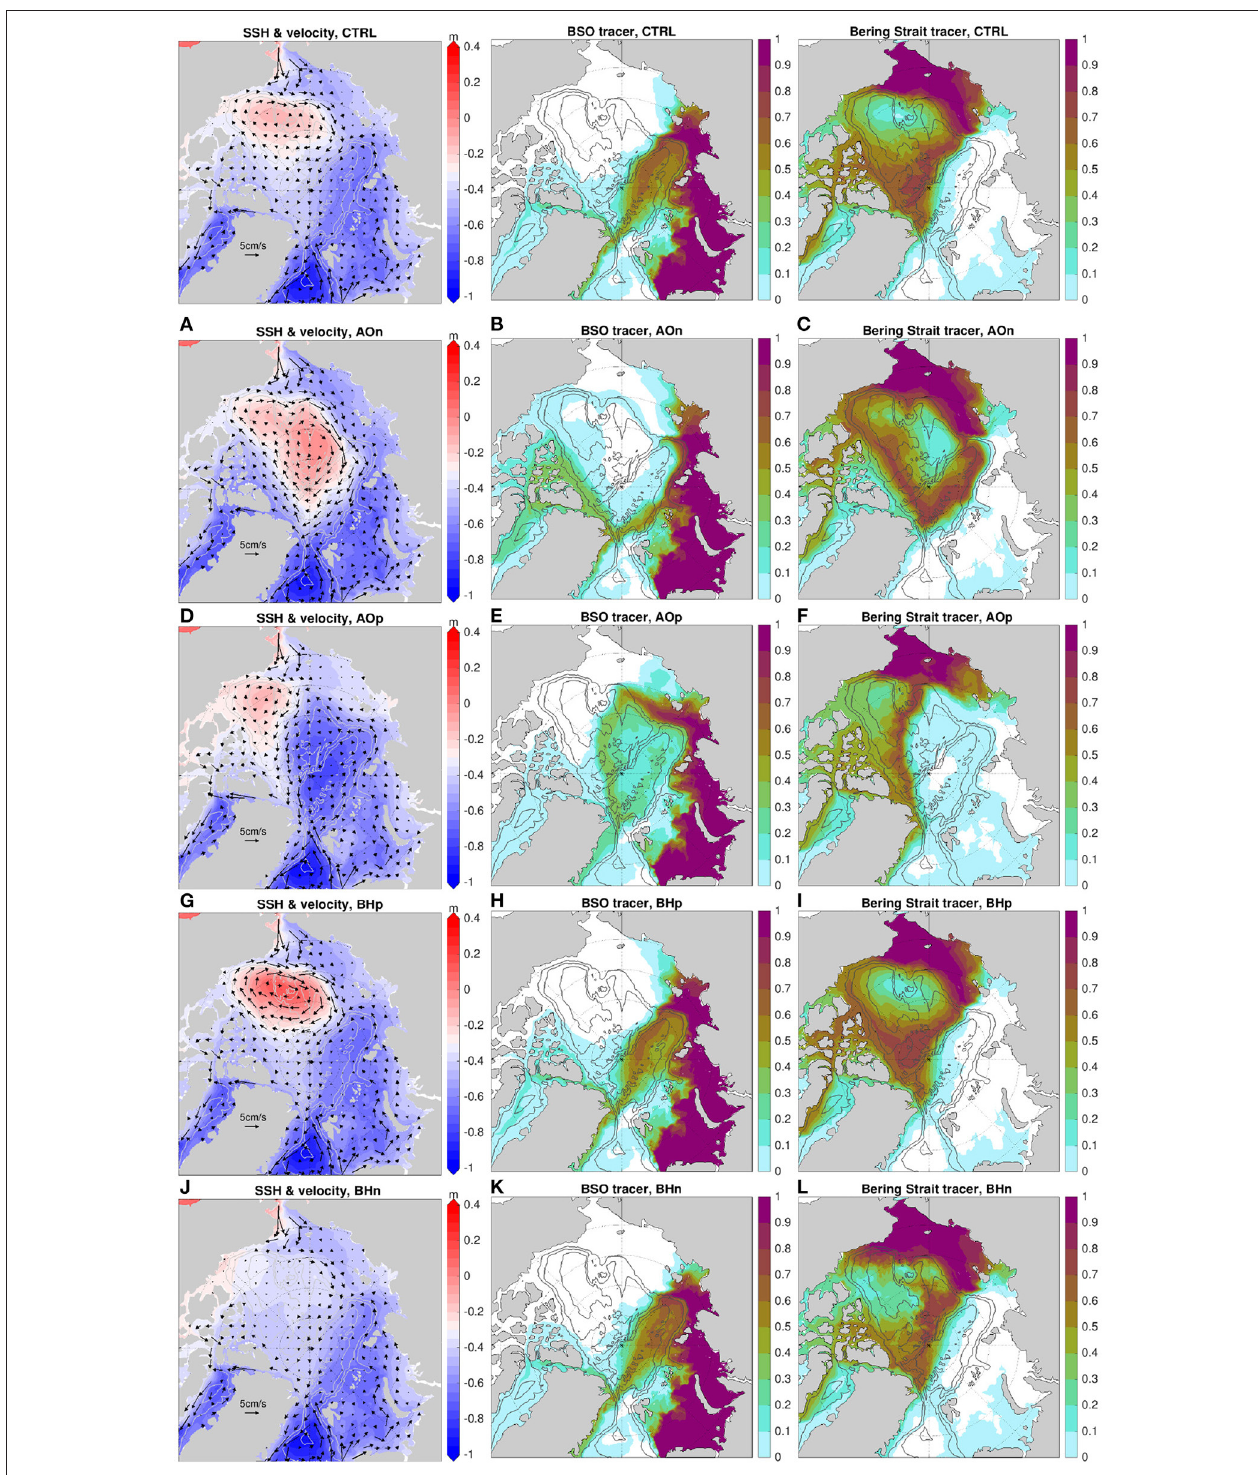
FIGURE 6 | Left: Sea surface height (SSH) and upper 150 m mean velocity in the last model year. Middle column: The upper 150 m mean value of Barents Sea Opening (BSO) passive tracer concentration in the last model year. Right: The upper 150 m mean value of Bering Strait passive tracer concentration in the last model year. (A–C) : the case with negative Arctic Oscillation (AO) forcing. (D–F) : the case with positive AO forcing. (G–I) : the case with positive Beaufort High (BH) forcing. (J–L) : the case with negative BH forcing. The control run results are shown in the top row of the figure for reference. The 500, 2,000, and 3,500 m isobaths are shown with gray contour